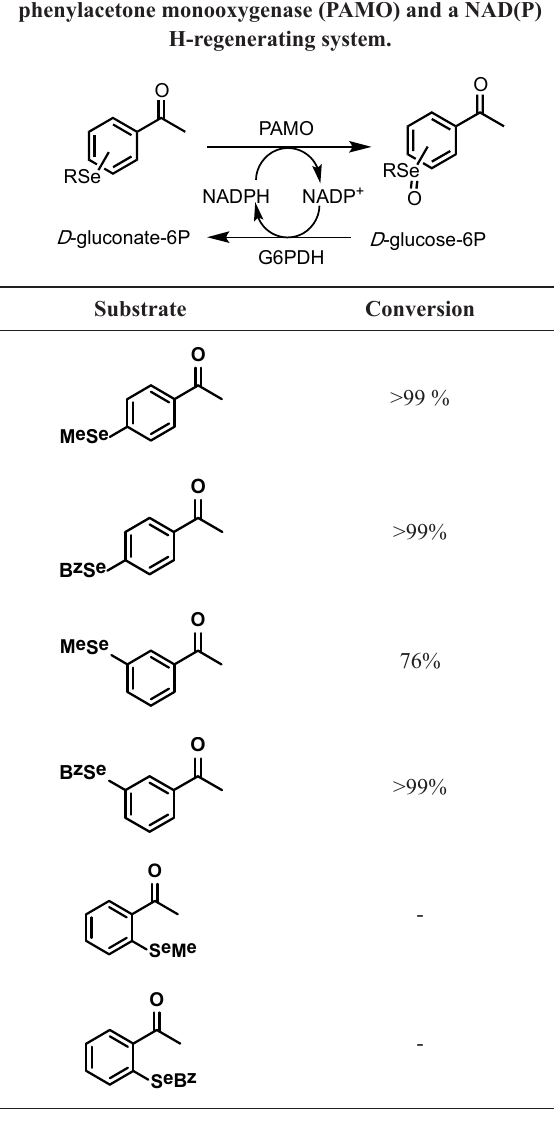
Oxidation of organoselenium acetophenones using phenylacetone monooxygenase (PAMO) and a NAD(P) H-regenerating system.